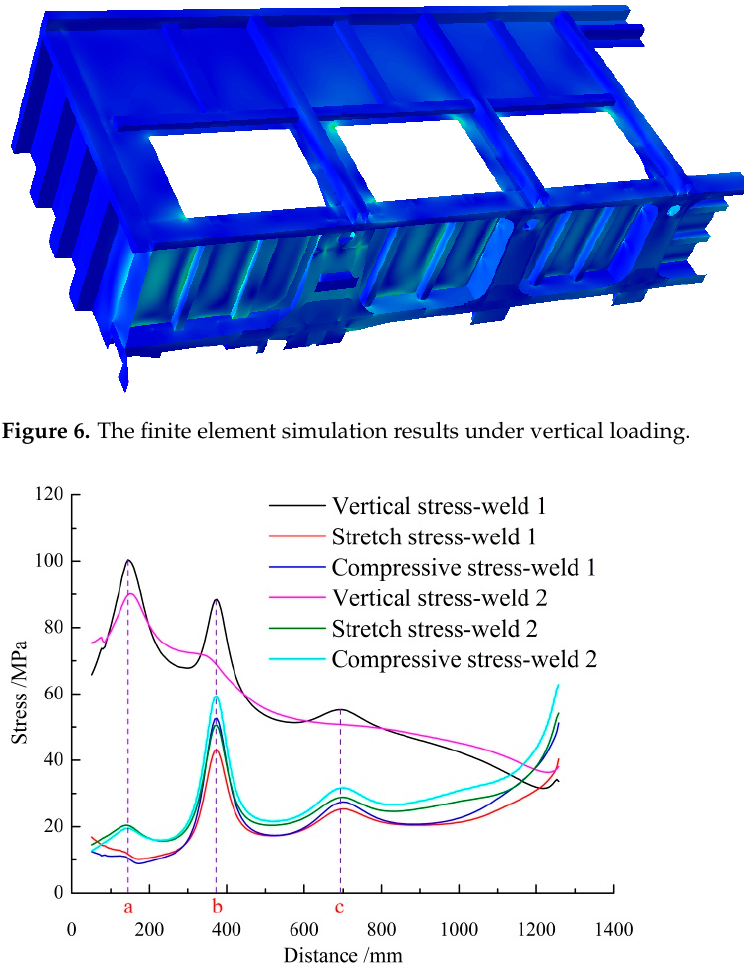
Figure 7. The stress distribution of bolster beam welds: (a) the distance between side sill and outer edge of interior reinforcement; (b) the distance between side sill and partition 1; (c) the distance between side sill and partition 2.